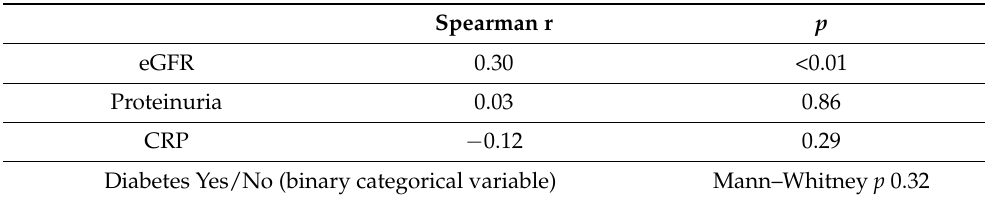
Table 3. Relations between Nrf2 protein concentration and selected clinical parameters in patients with CKD (n = 75).